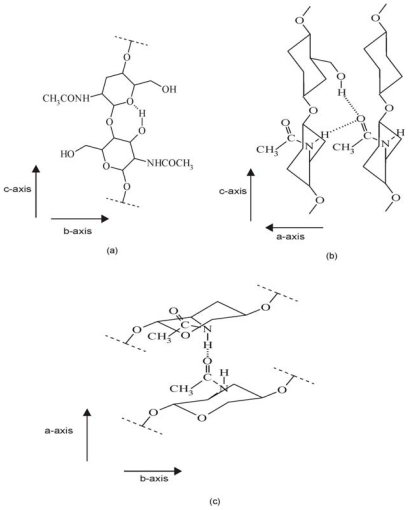
Modes of hydrogen bonding in β-chitin: (a) intrachain C(3′)OH···OC(5) bond; (b) interchain C(21)NH···O=C(73) bond and C(6′1)OH···O=C(73) bond (ac plane projection); (c) interchain C(21)NH···O=C(73) bond (ab plane projection). Adapted with permission from Biomacromolecules. 2000, 1, 609–614. Copyright 2010, American Chemical Society [18].